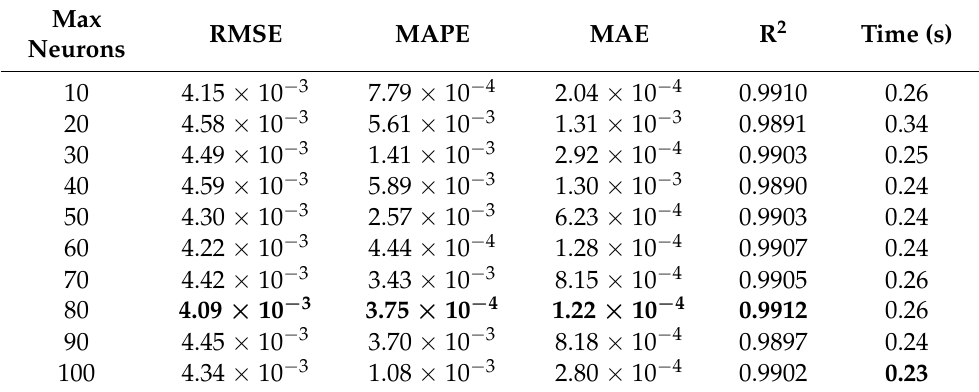
Table 3. Evaluation of GMDH